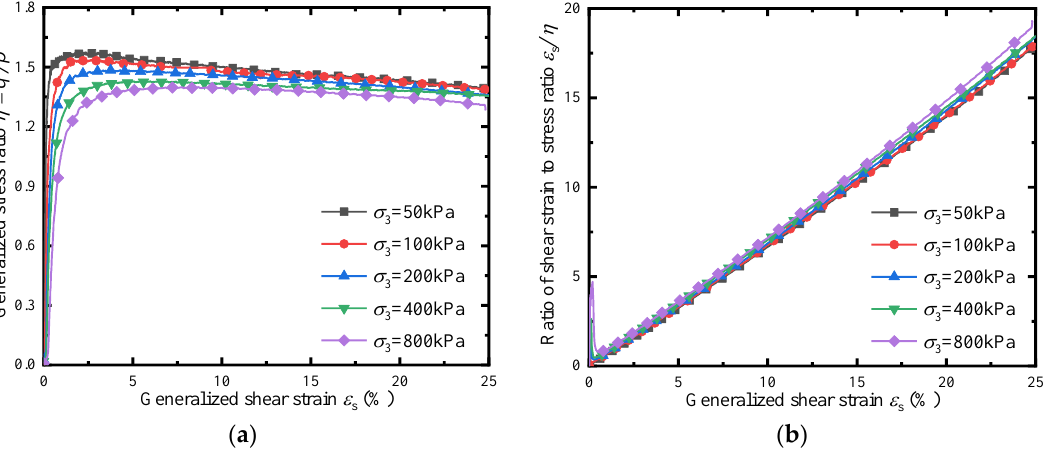
Figure 9. η - ε s relationships and ε s / η - ε s relationships under undrained condition. ( a ) η - ε s relationships under undrained condition. ( b ) ε s / η - ε s relationships under undrained condition.